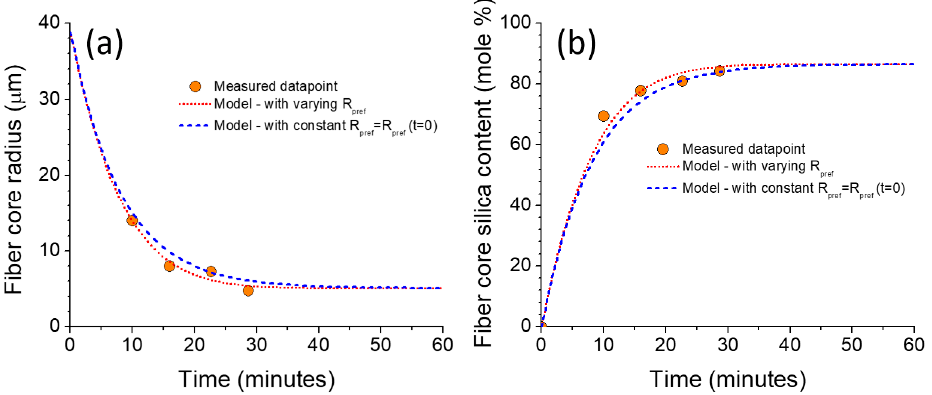
Figure 2. ( a ) Evolution of fiber core radius and ( b ) fiber core silica content as a function of draw time. Fit (red curve in ( a )) performed using Equation (4) to determine R 0 , R s , and D . These parameters are thus used to fit the red curve in ( b ). More details can be found in the text.